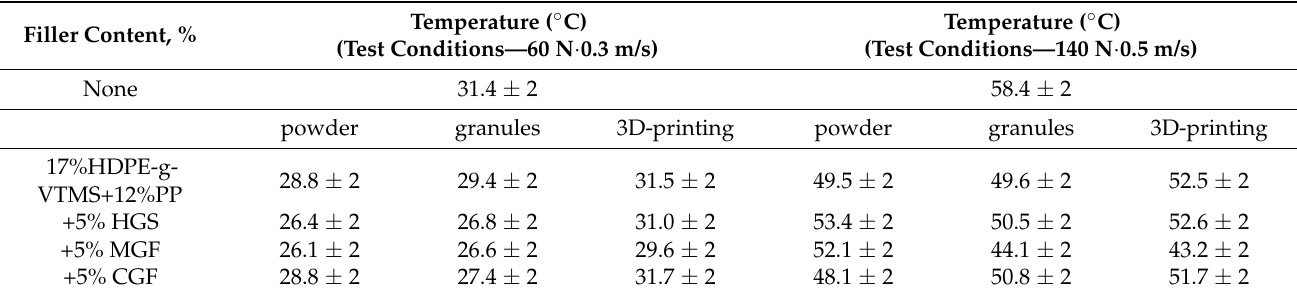
Table 8. The counterpart temperatures upon friction on neat UHMWPE and the ‘UHMWPE+17%HDPE-g-VTMS+12%PP’- based composites under various tribological conditions. The ‘block-on-ring’ scheme. Filler Content,